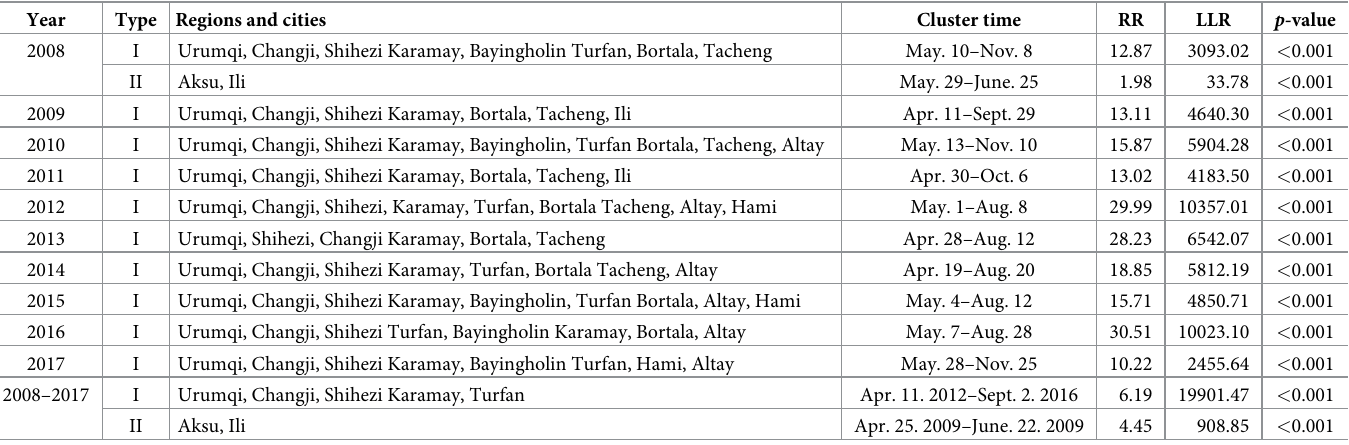
Table 2. Spatiotemporal clusters of the HFM